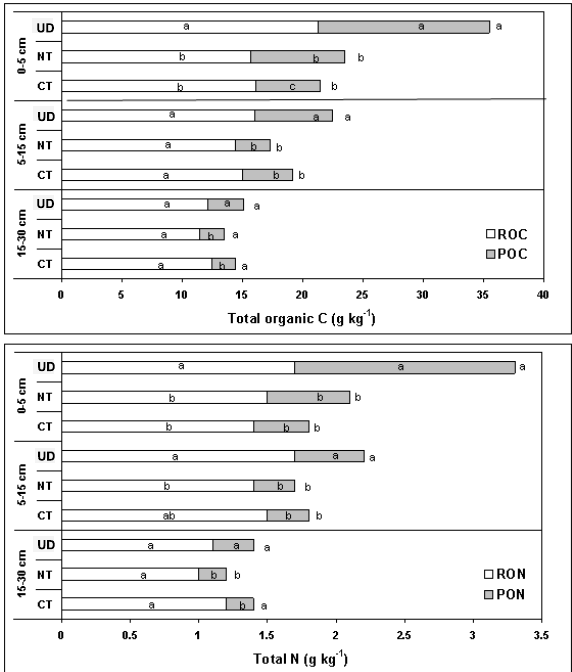
Figure 2. Concentrations of (a) total organic carbon content (TOC) as the sum of particulate organic carbon (POC) and resistance organic carbon (ROC) and (b) total nitrogen (TN) as the sum of particulate organic nitrogen (PON) and resistance organic nitrogen (RON) in soil from three different layers and for different management strategies. NT: untilled soils (n=22); CT: conventionally tilled soils (n=18); UD: undisturbed soils (n=7). Different letters indicate statistical differences between management strategies within a soil layer (Tukey test p < 0.05). Each C and N component, as well as total C and N, were analyzed